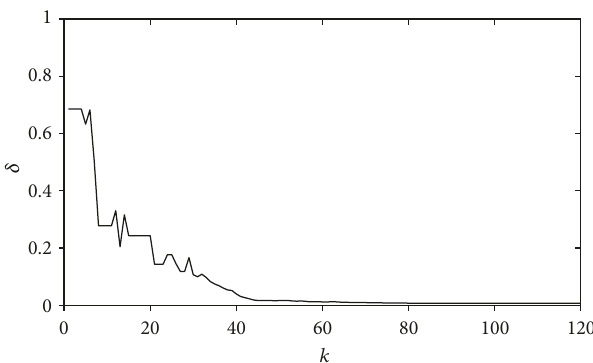
Figure 4: The PSOI estimation errors versus k